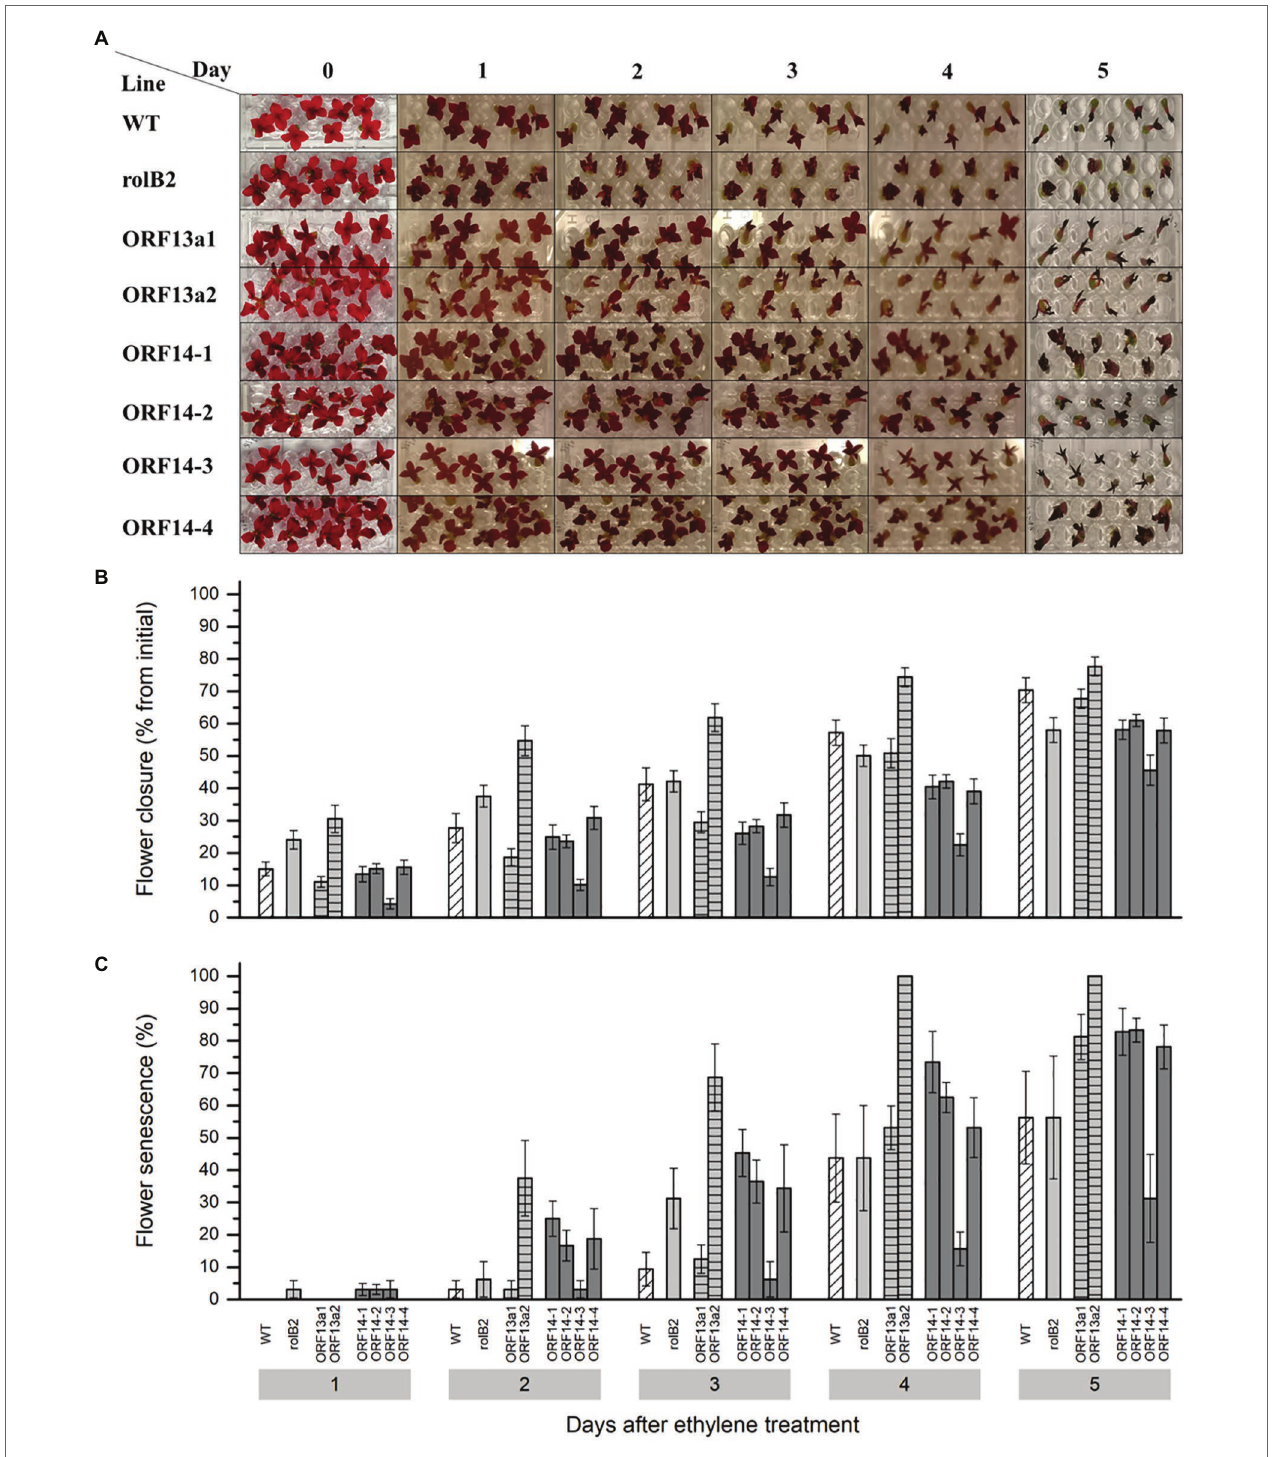
FIGURE 5 | Ethylene sensitivity among the rol genes/ORFs overexpressing lines. (A) Exogenous ethylene (0.5 μ l L −1 ) applied to detached K. blossfeldiana ‘Molly’ flowers of WT and overexpressing lines ( rol B2, Δ ORF13a-1, Δ ORF13a-2, ORF14-1, ORF14-2, ORF14-3, and ORF14-4) placed in micro titer plates with water inside a hermetic sealed glass tank. A control group of the same genotype consisted of the same setting without the addition of ethylene. (B) Flower diameter was collected daily for 5 days after sealing the glass tanks and the flower closure is presented as percentage from the initial diameter of ethylene exposed flowers. (C) Senescent detached flower percentage on each evaluation day. Data columns represent the difference average ± SE ( n = 8–10) and different lower case letters represent statistical significance using Scott-Knot test ( p ≤ 0.05) within the time